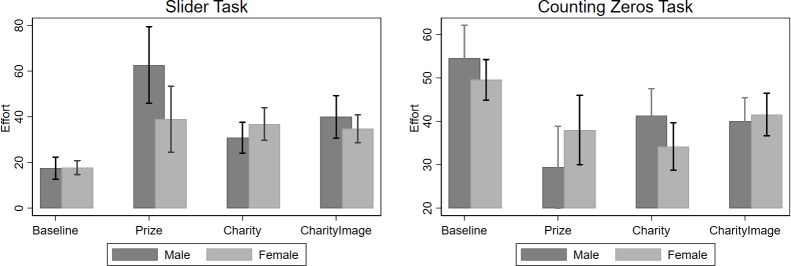
Effort allocations in the multi-task part by gender.